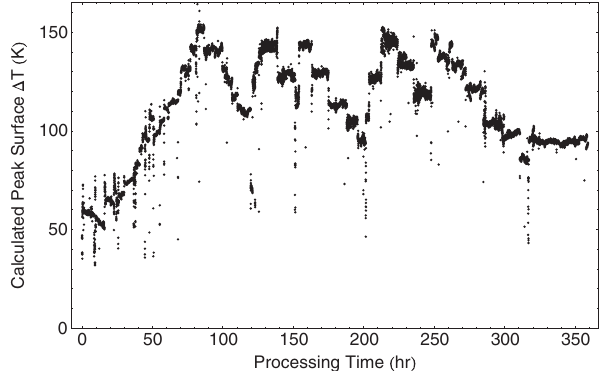
FIG. 16. Calculated peak surface temperature rise due to pulsed heating in the PBG-E